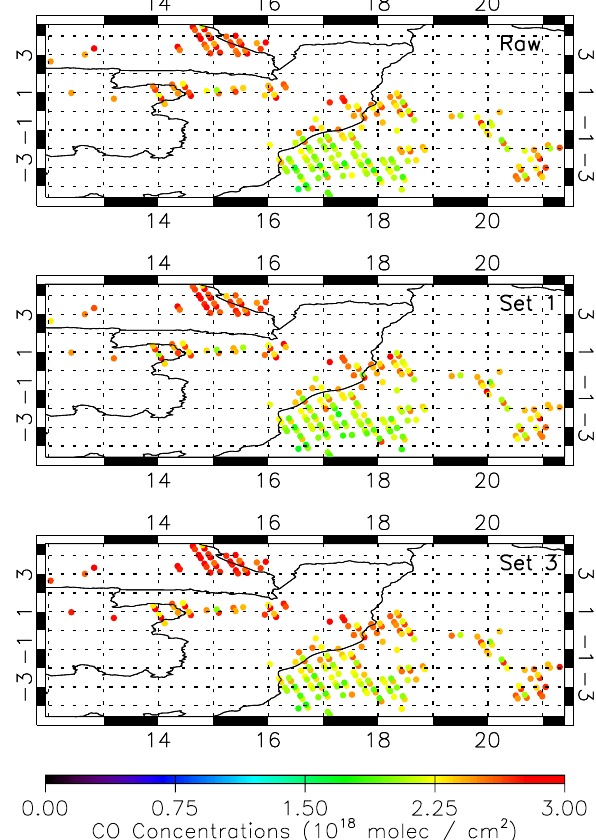
Fig. 9. Raw and reconstructed brightness temperature spectra (left) and the difference between them (right) for an enhanced CO ob- servation. Set 3 eigenvectors were used. CO absorption lines are marked with vertical dashed lines. The set 3 noise level is plotted as a dotted line in the difference plot.